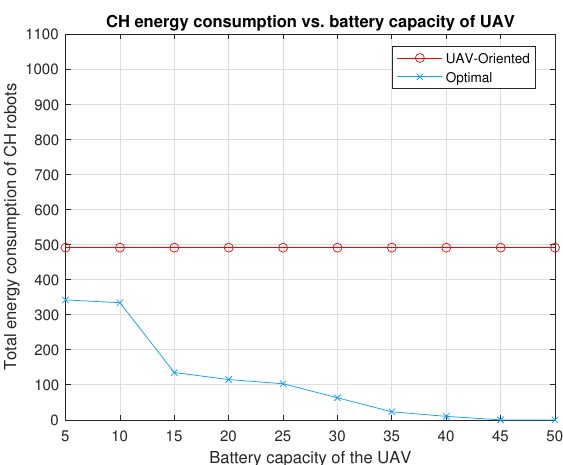
Figure 8. The total energy consumption of the 10 CH robots in Figure 7 under the strategies, UAV-oriented and optimal for varying battery capacities of the UAV from B = 5 × C UAV to B = 50 × C UAV